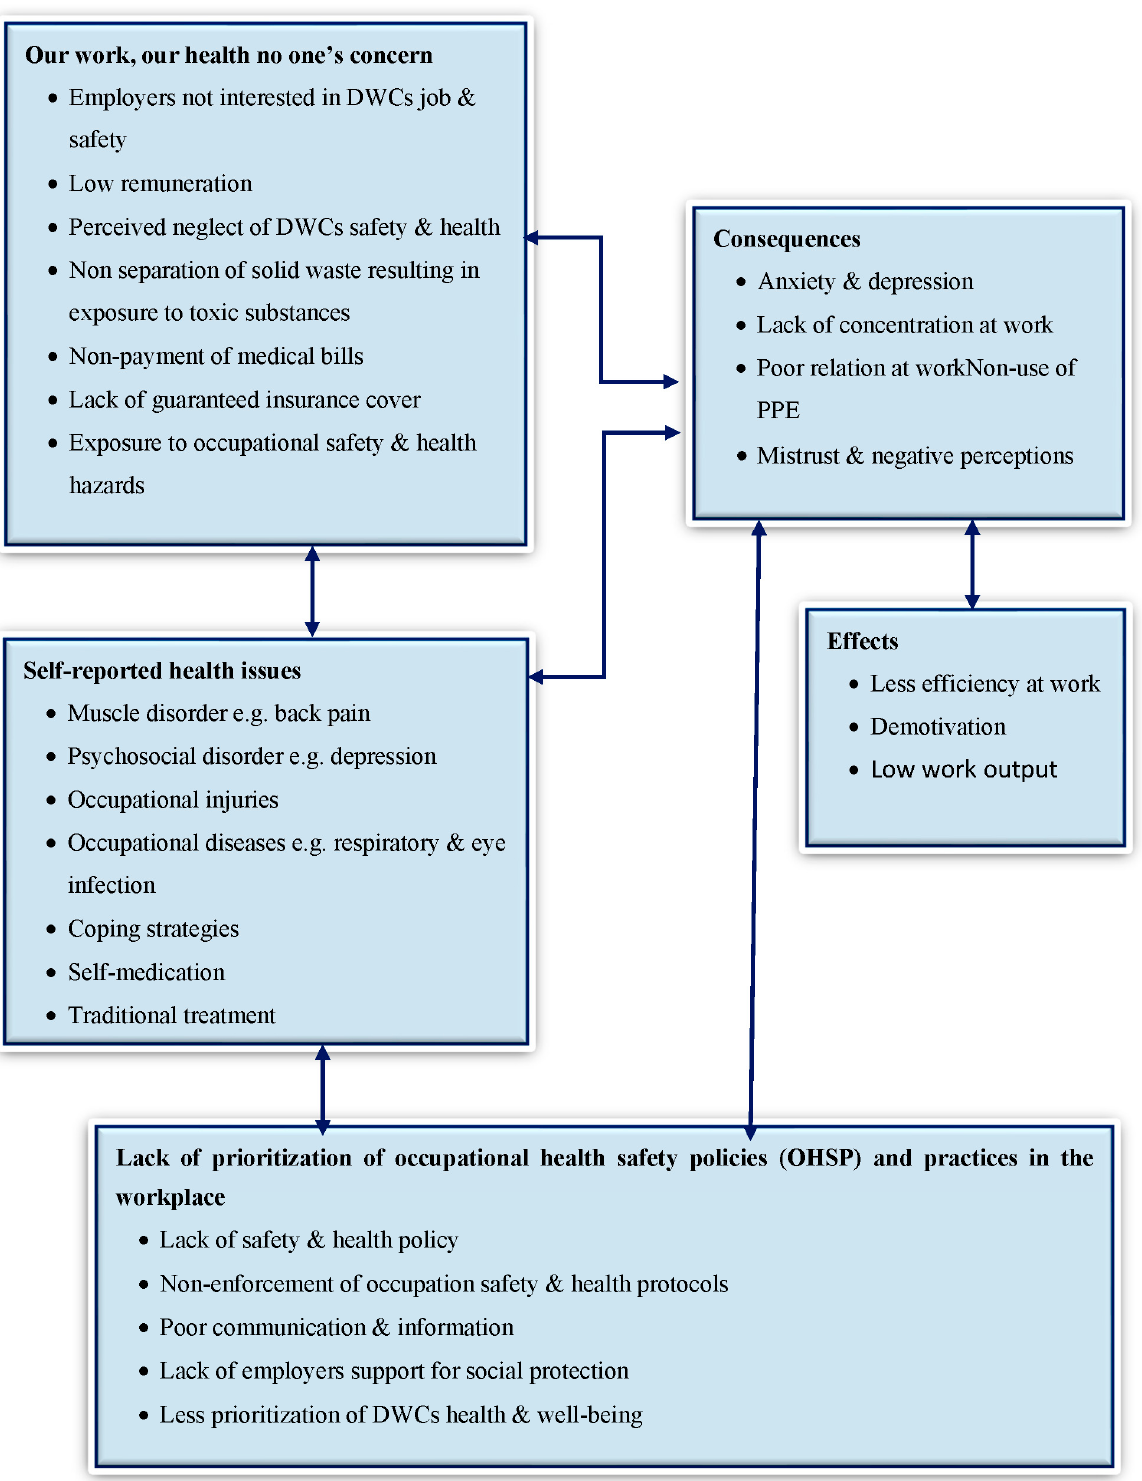
Figure 1. Presents a framework of factors in the study that influence DWCs’ perceptions of occupa- tional safety and self-reported health outcomes.